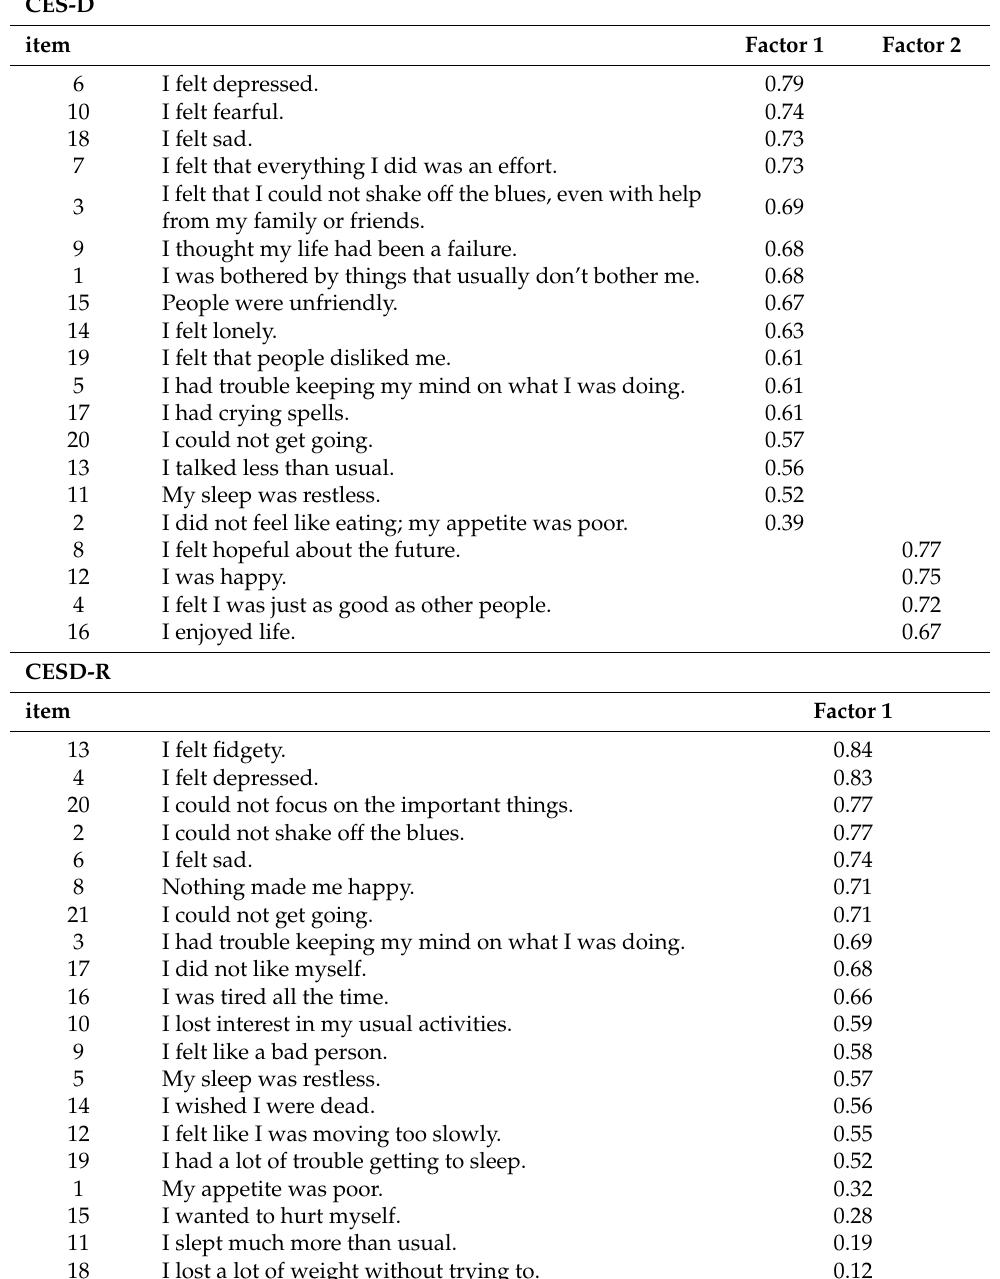
Table 2. Main factors of the CES-D and CESD-R